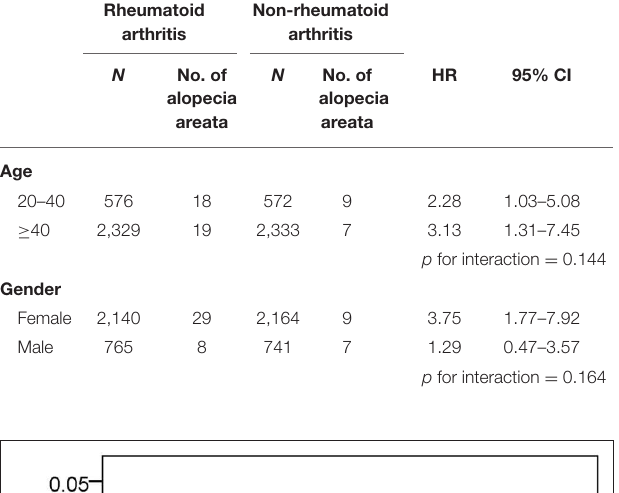
TABLE 3 | Subgroup analysis of Cox proportional hazard model stratified by sex and age.